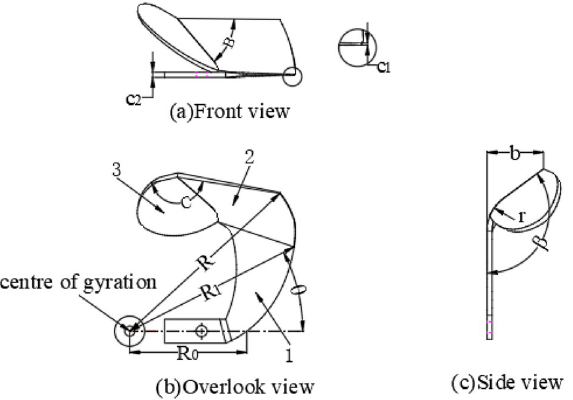
Figure 2. Paddy field blade structure. 1. Side cutting surface; 2. Front cutting surface; 3. Mud splashing board. B is the angle between the front cutting edge and the mud splashing board (°), C is the angle between the front cutting surface and the mud splashing board (°), R 0 is the starting radius of the side cutting edge (mm), R 1 is the ending radius of the side cutting edge (mm), R is the radius of gyration of the knife roll (mm), θ is the wrap angle of the side cutting edge (°), c1 is the thickness of the cutting edge (mm), c2 is the thickness of the knife handle (mm), b is the working width (mm), r is the bending radius (mm), and β is the bending angle of the front cutting surface (°).